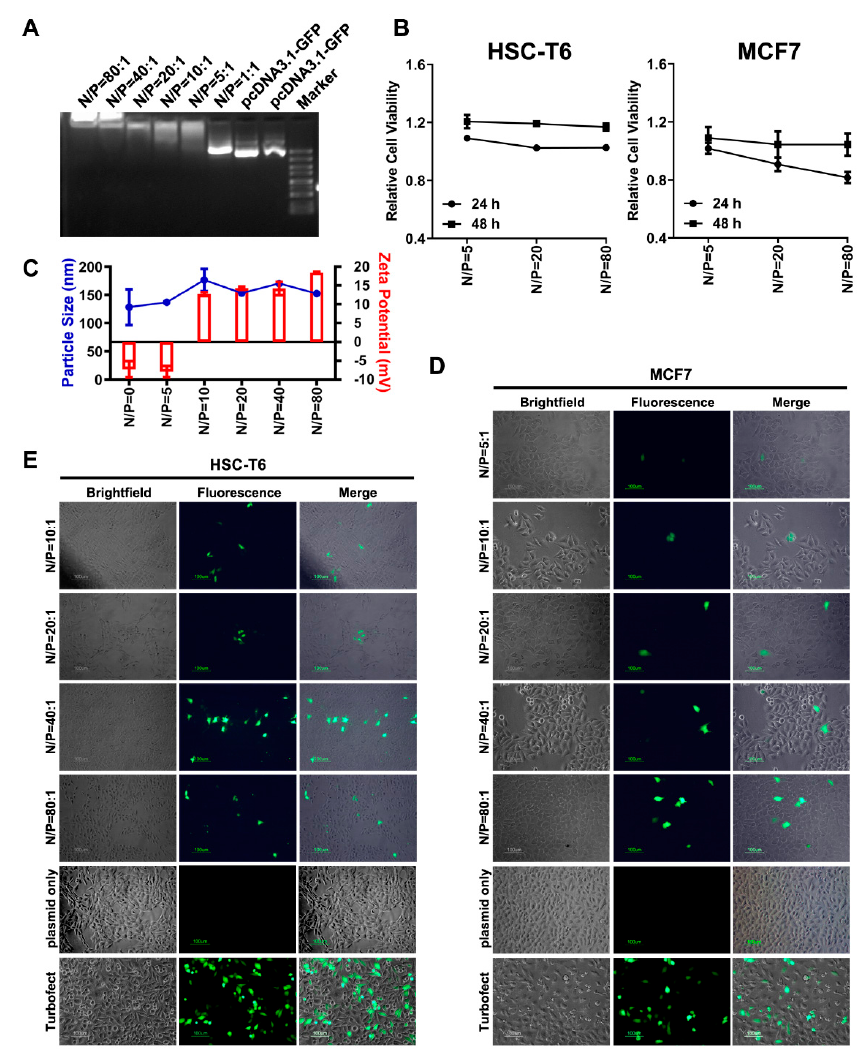
Figure 6. Dot1l-mediated plasmid delivery. ( A ) Gel retardation assay on different N/P ratios of Dot1l peptide and pcDNA3.1-GFP. ( B ) Cell viability of HSC-T6 and MCF7 cells treated with Dot1l peptide